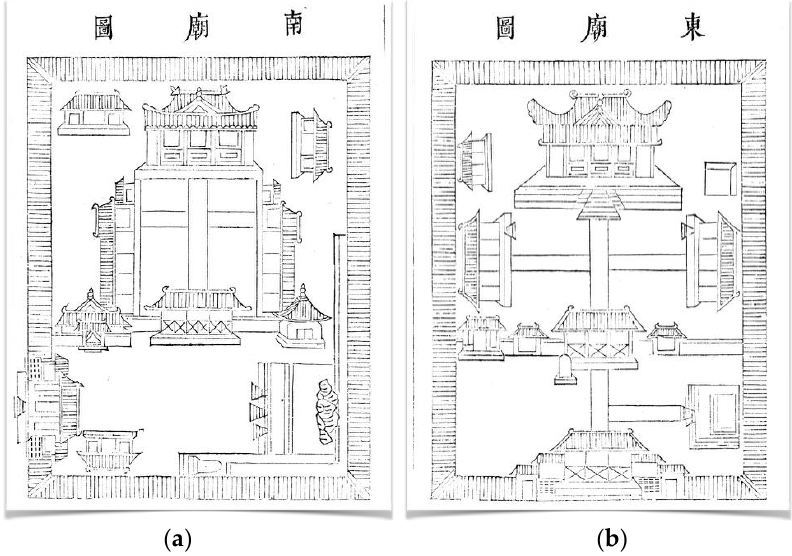
Figure 3. The South Shrine ( a ) and the East Shrine ( b ). ( Continuation of the Illustrated Records of